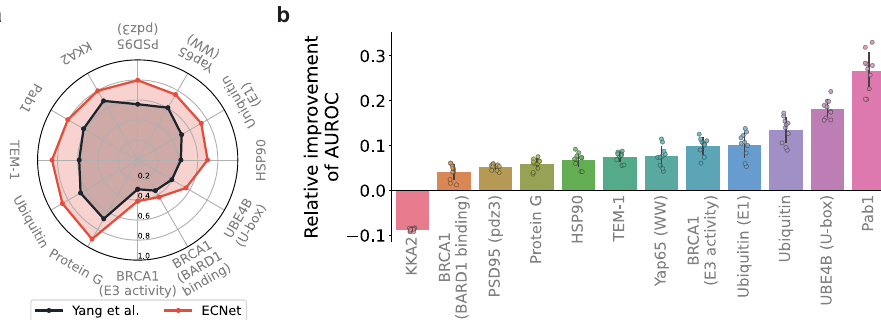
Fig. 2 Comparisons to other protein variant representation methods. a Comparison to the approach from Yang et al. 44 that represents protein sequences with fi xed-length vector representations by training a Doc2Vec model on the UniProt database. Spearman correlation was used as the evaluation metric. Performances were evaluated using fi ve-fold cross-validation. b Comparison to the Envision model 35 that represents a variant with 27 biological, structural, and physicochemical descriptors. AUROC (area under the receiver operating characteristics) was used as the evaluation metric to assess the ability of the model in identifying variants with improved function compared to the wild type. Relative improvements achieved by ECNet over the Envision model were shown in the bar plot. Performances were evaluated using ten trials of fi ve-fold cross-validation. The bar plot represented the mean ± SD of